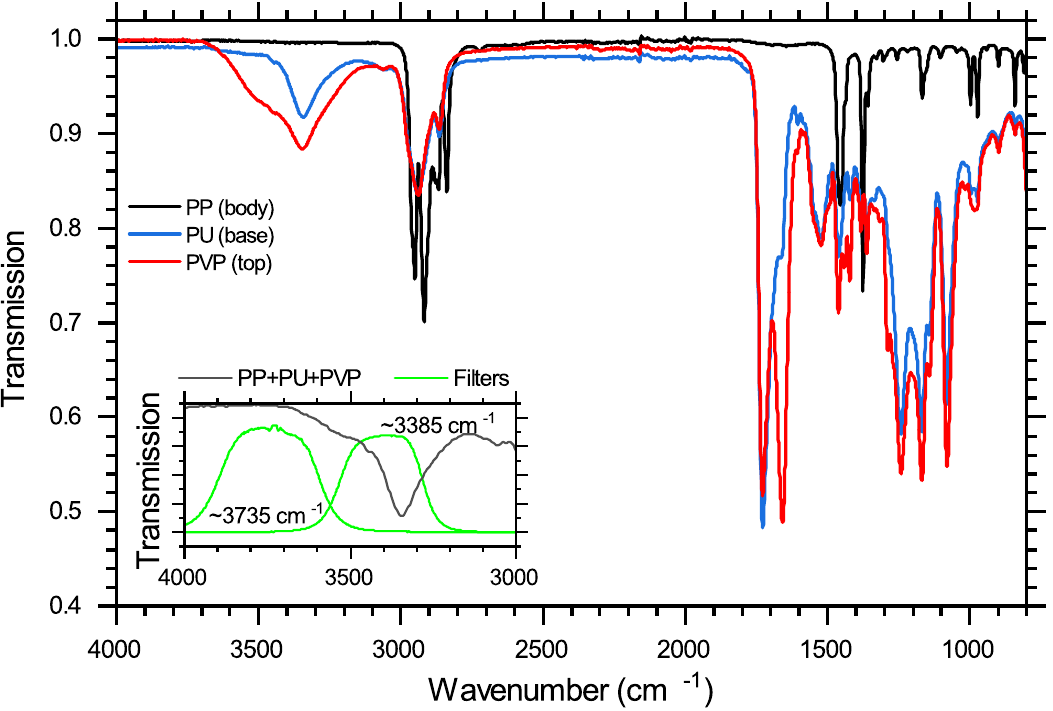
Figure 3. ATR transmission spectra of separate PP, PU, and PVP material samples. The insert shows transmission spectra of a full coated nozzle bevel tip and filters employed for measuring transmission in the range of PU/PVP absorption, centred at ≈ 3385 cm − 1 , and in the range where only scattering by PP/PU/PVP occurs, centred at ≈ 3735 cm − 1